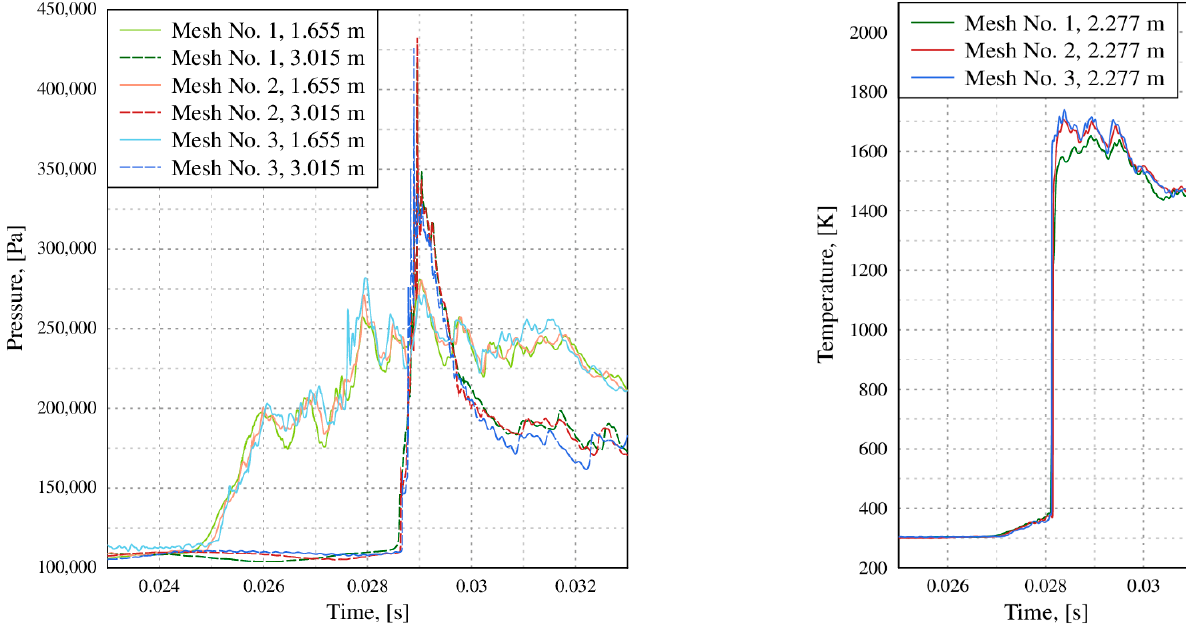
Figure 4. Comparison of pressure and temperature evolutions with different meshes in selected points (0% diluents, Zimont correlation).